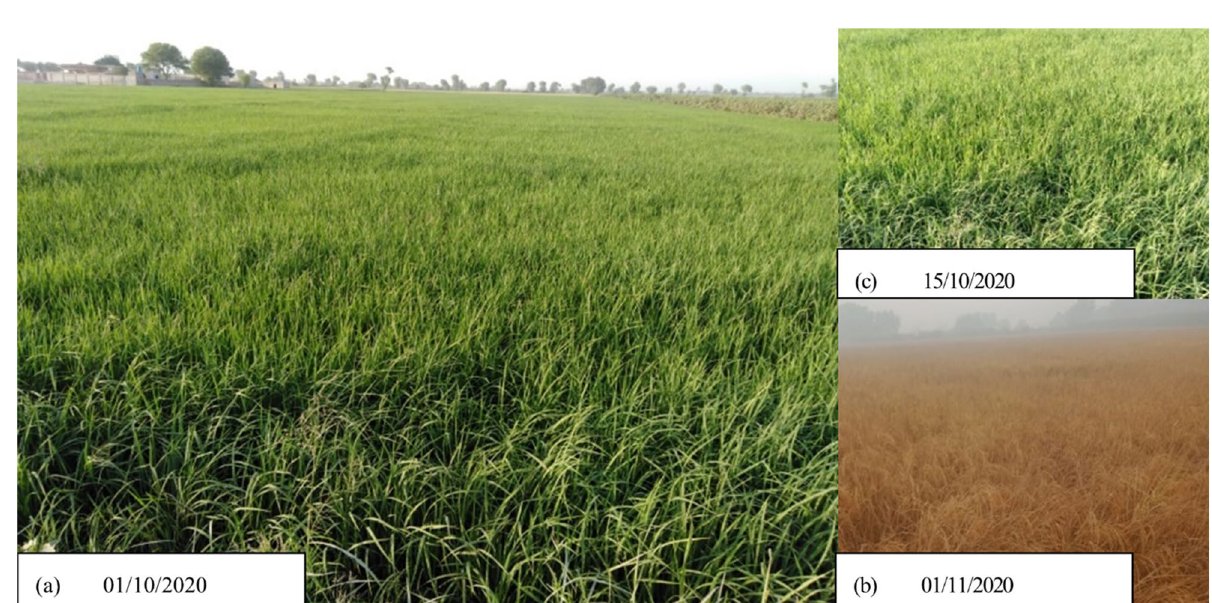
Figure 7. Ricefield photographs, taken during training sample collection at different locations and timeperiod within the study area. The photographs ( a – c ) are taken by first author, during the field